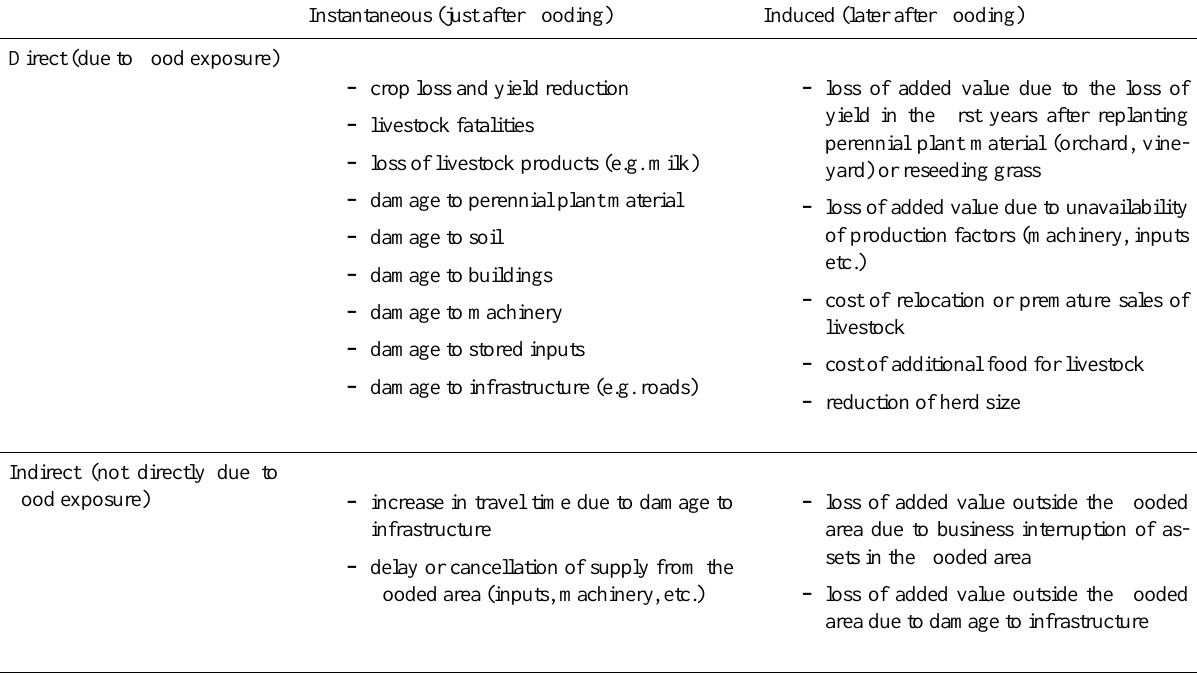
Table 1. Classification of flood damage to agriculture Instantaneous (just after flooding) Induced (later after